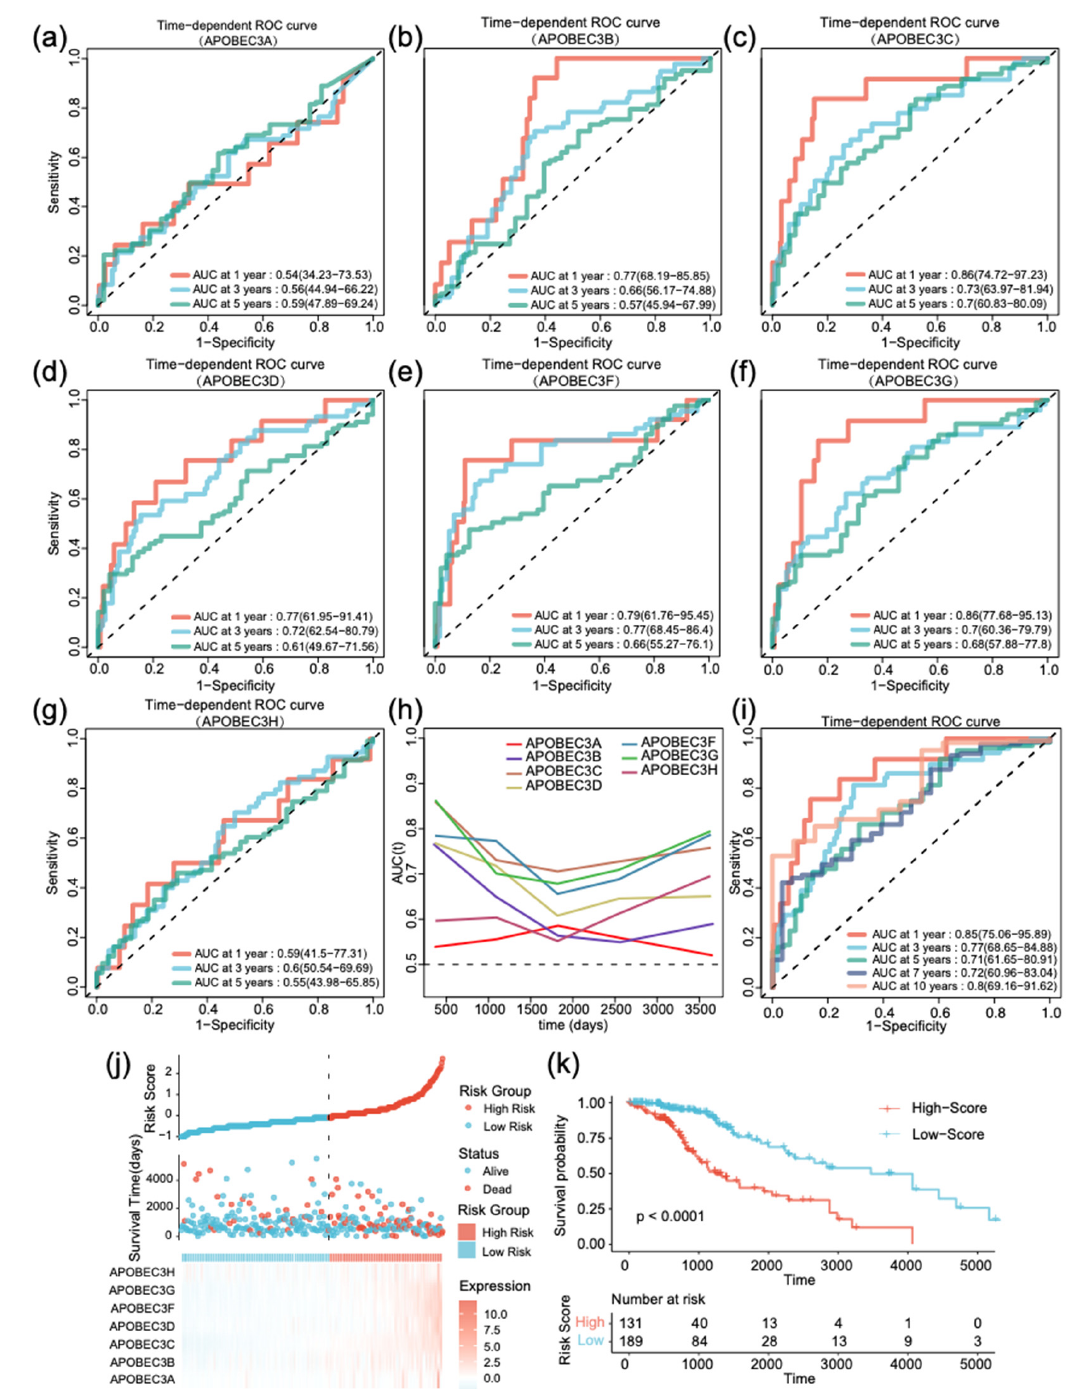
Figure 3. Development of APOBEC3 signature and survival prediction of patients with low-grade gliomas in TCGA training cohort. Time-dependent ROC curve when using ( a ) APOBEC3A, ( b ) APOBEC3B, ( c ) APOBEC3C, ( d ) APOBEC3D, ( e ) APOBEC3F, ( f ) APOBEC3G, and ( g ) APOBEC3H alone to build risk prediction model. ( h ) The area under ROC curve (AUC) of prognosis prediction using different APOBEC3 family members in TCGA data set. ( i ) Time-dependent ROC curve of APOBEC3 signature at 1, 3, 5, 7, and 10 years in TCGA training cohort. ( j ) Distribution of risk score, survival time, and gene expression panel. ( k ) Kaplan–Meier curves of overall survival (OS) in low-grade glioma based on risk